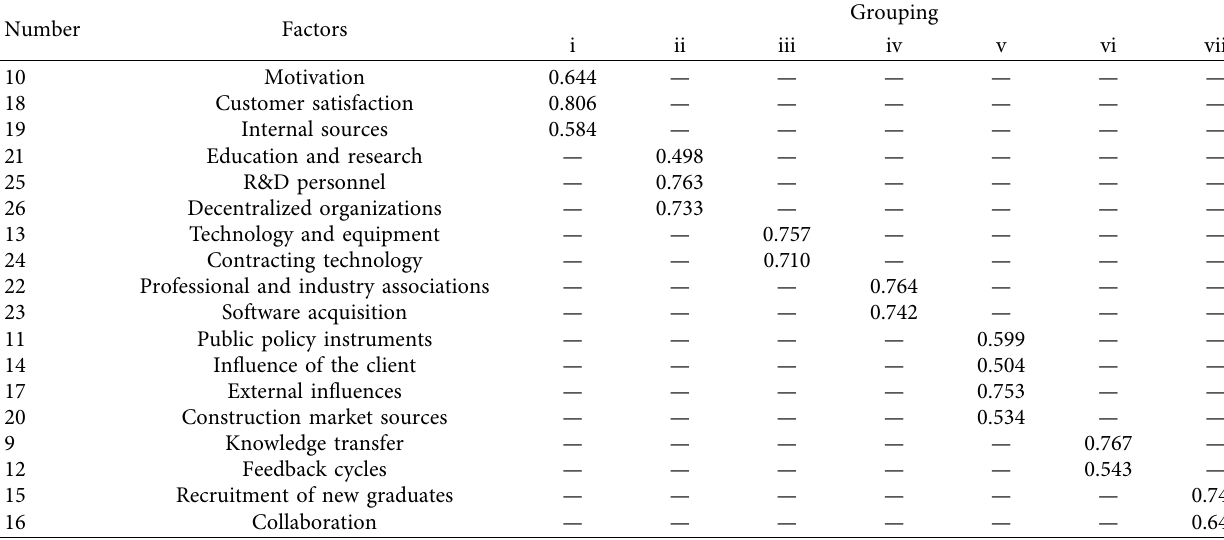
Table 5: Grouping matrix after varimax rotation.